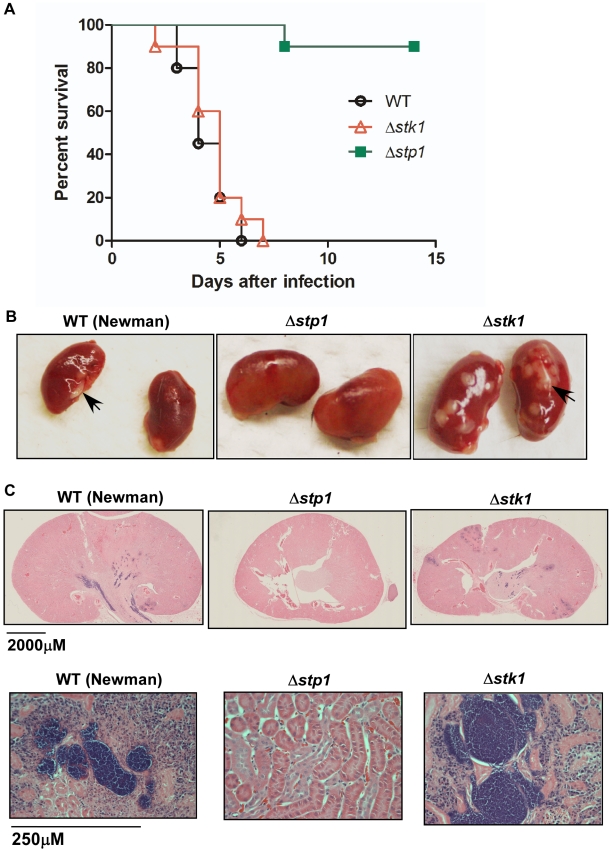
Stp1 is important for virulence of S. aureus.(A) Ten, six week-old female C57BL/6J mice were intravenously injected with 2–5×107 CFU of S. aureus WT, Δstp1 or Δstk1 strains. As a control, ten mice were inoculated in parallel with PBS. Kaplan-Meier survival curves show the percent survival of mice after the infection. Note that 100% of mice infected with the WT and Δstk1 strains succumbed to infection, in contrast to only 10% of mice infected with the Δstp1 mutant. Survival of mice infected with the Δstp1 mutant was significantly different from that of the WT and the Δstk1 mutant (P value<0.0001, log rank test). However, mice infected with the Δstk1 mutant did not show a significant difference in survival compared to the WT (P value = 0.44, log rank test). (B) Kidneys harvested from the mice that were moribund or at the end of the experiment. Arrows represent abscesses that were observed on the infected kidneys. Note that a large number of abscesses are seen in the kidneys of mice infected with the Δstk1 mutant in comparison to those infected with the Δstp1 strain. One representative from ten infected kidney pairs after inoculation with the S. aureus strain is shown. (C) Histological examination of infected renal tissue was performed at 5 days post-infection. Kidneys were fixed in formalin, embedded in paraffin, thin-sectioned, stained with hematoxylin and eosin (H&E), and examined by microscopy as described previously [69], [97]. Abscesses and necrotic tissue are observed in kidneys of mice infected with WT and Δstk1 strains but not with the Δstp1 mutant.